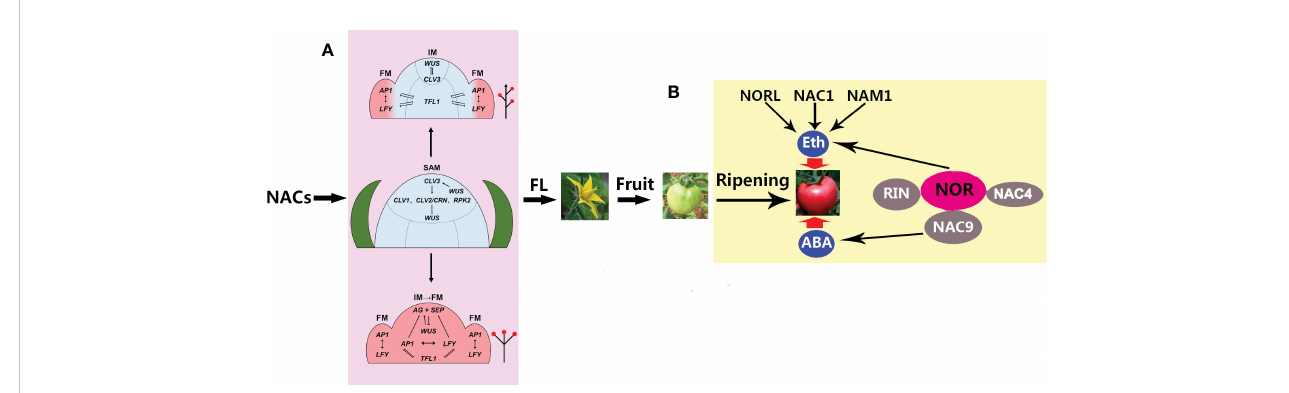
FIGURE 2 A model for the roles of NACs (NAM, ATAF, and CUC) in fl ower formation and ripening. (A) NACs control the transition of the shoot apical meristem (SAM) to the fl oral meristem (FM), including indeterminate in fl orescence ( up arrow ) and determinate in fl orescence ( down arrow ) (Ma et al., 2017). By controlling the relative expression levels of TFL1 (TERMINAL FLOWER 1) and the FM identity genes, AP1 and LFY (APETALA1 and LEAFY, respectively), in the distal in fl orescence meristem (IM), the IM can remain meristematic and generate different numbers of FMs before converting to a terminal fl ower. A higher relative expression ratio prevents the expression of the FM identity genes LFY and AP1 in the distal IM during the onset of indeterminate in fl orescence. However, during determinate in fl orescence development, the expression of the FM identity genes in the distal IM can evoke the expression of the C class AGAMOUS ( AG ) and E class SEPALLATA ( SEP ) genes, thus determining the fl oral fate of the apical meristem. FL , fl owering. (B) NACs control tomato fruit ripening through ethylene (ETH) and abscisic acid (ABA), which are involved in NOR, NORL, RIN, NAM1, and NAC1/4/9. NOR, RIN, and NAC4/9 constitute an interaction complex in which NOR, together with NORL, NAC1, and NAM1, regulates ripening through ETH, while NAC9 regulates ripening through ABA. NOR, non-ripening mutant; NORL, NOR-like; NAM, no apical meristem; RIN ripening